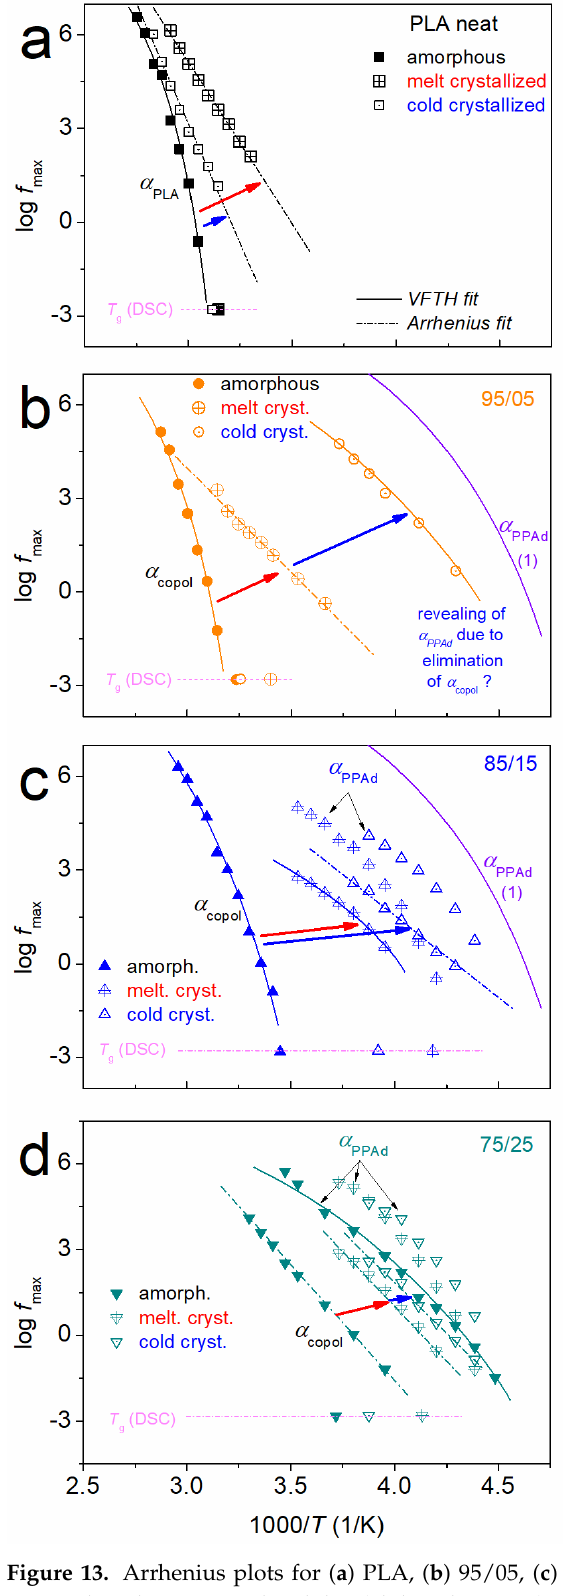
Figure 13. Arrhenius plots for ( a ) PLA, ( b ) 95/05, ( c ) 85/15 and ( d ) 75/25, showing the effects imposed on the segmental mobility (alpha relaxations) of initially amorphous samples by melt- and cold-crystallization (arrows). The added line (1) in ( b , c ) is the VFTH fitting result of α PPAd of the initial PPAd.